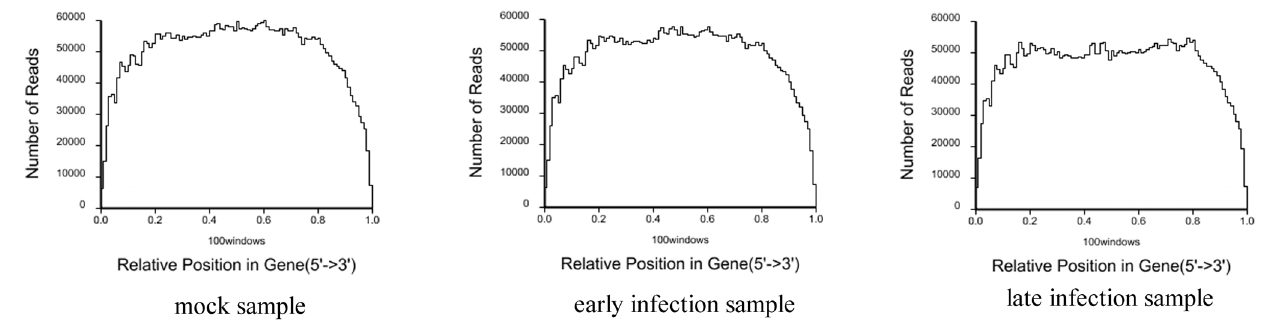
Figure 6. Distribution statistics of reads mapped to reference genes. The horizontal axis represents the relative reads position which is calculated as the ratio between reads location on the gene and gene length; the vertical axis represents the number of reads that mapped to genes.